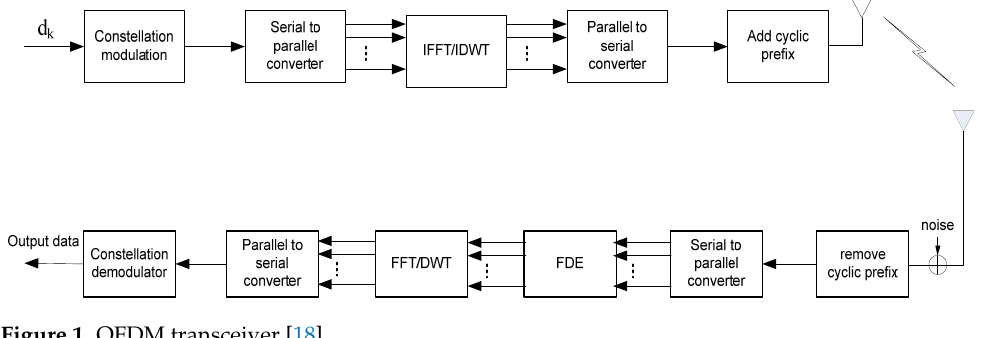
Figure 1. OFDM transceiver [18].